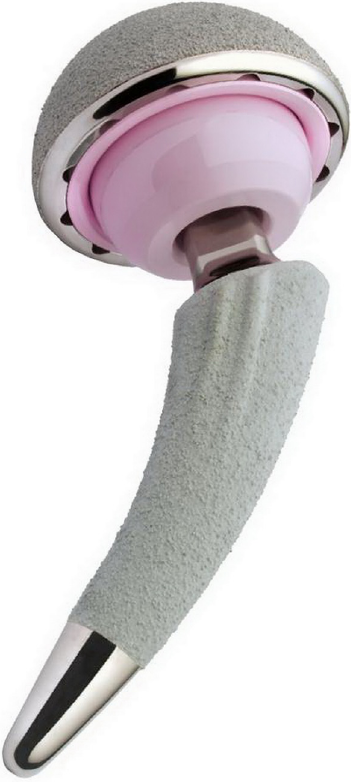
Figure 1. MiniHip TM (Corin Group PLC, Cirencester, UK).